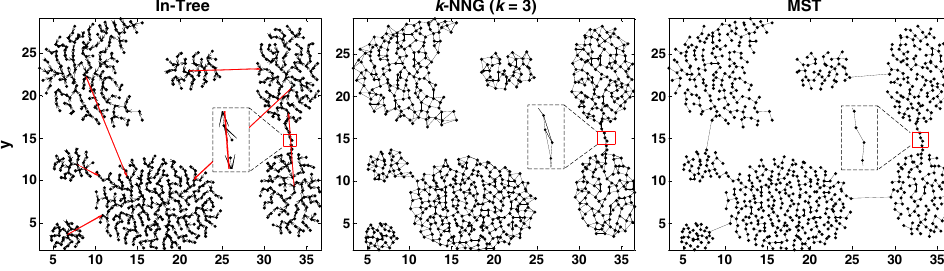
Figure 4. Comparison between the physically inspired In-Tree ( left ), k -NNG ( middle ) and MST ( right ). Unlike the physically inspired In-Tree whose inter-cluster edges (in red) are relatively longer than the rest inter-cluster edges, both k -NNG and MST contain very short inter-cluster edges (see the local areas circled by the red